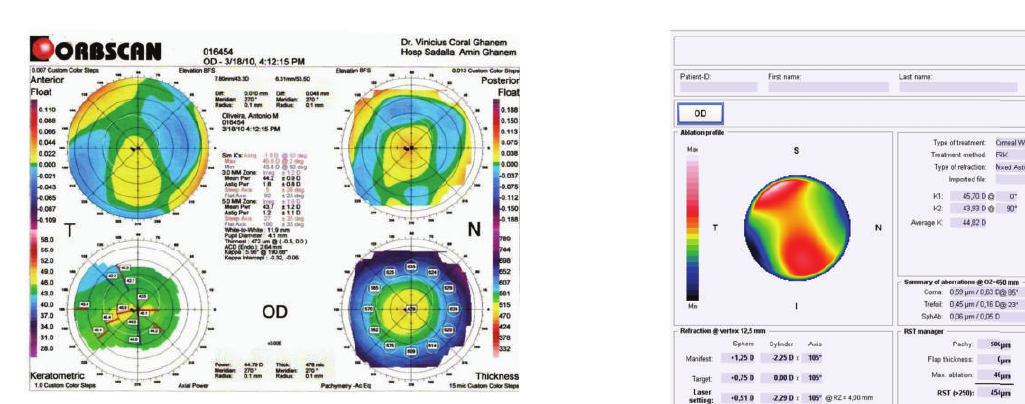
maximum ablation depth of 40.53 𝜇 m and central ablation of 30.07 𝜇